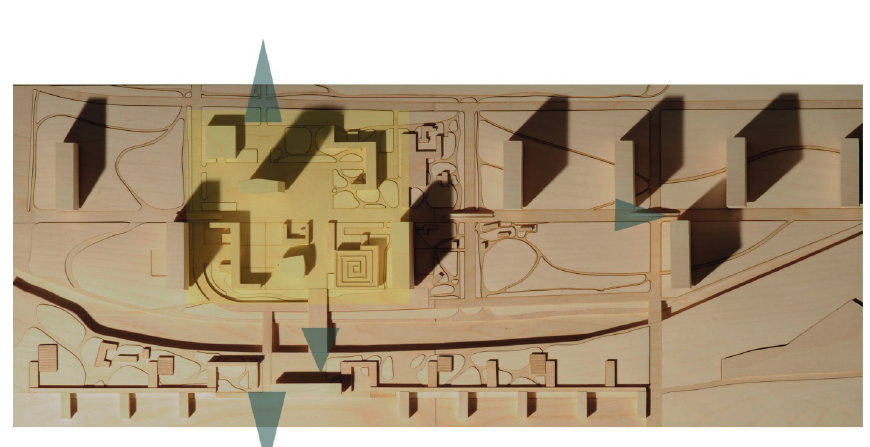
lour pedestrian areas. In yellow colour: main visual axes and meshes of geometric grid